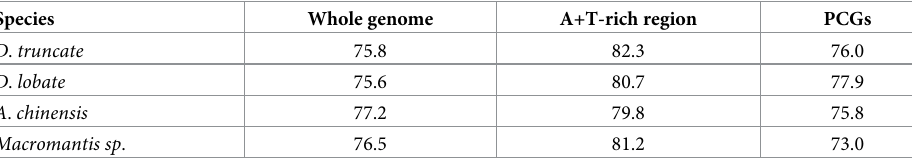
Table 2. A+T (%) composition of four mantodean mitochondrial genomes.